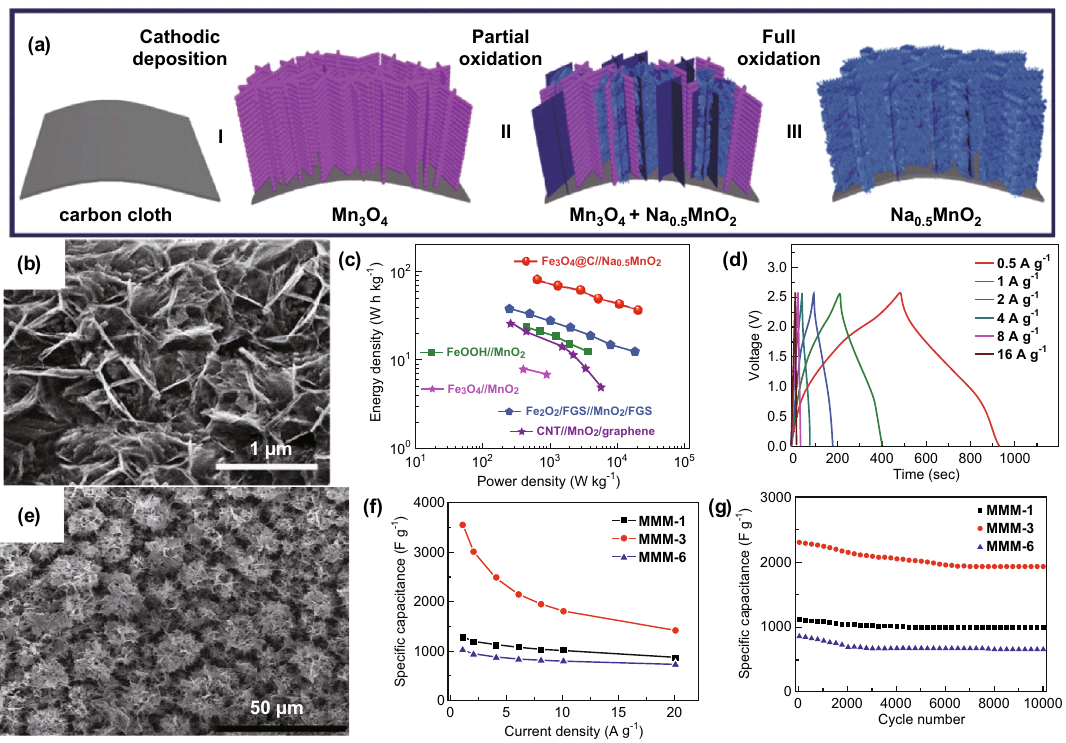
Fig. 4 3D architectures based on 2D transition metal nanoflakes and 3D skeleton ensembles for supercapacitors. a Schematic illustration of morphological evolution from Mn 3 O 4 nanowall arrays to Na 0.5 MnO 2 nanowall arrays through electrochemical oxidation. b FESEM images of Na 0.5 MnO 2 nanowall arrays. c Ragone plots for Na 0.5 MnO 2 //Fe 3 O 4 @C ASC and asymmetric supercapacitors reported in the literature. d Charge/ discharge curves for Na 0.5 MnO 2 //Fe 3 O 4 @C asymmetric supercapacitors between 0 and 2.6 V at different current densities. Reproduced with permission [70]. Copyright (cid:2) 2017, John Wiley & Sons, Inc. e SEM images showing the surface morphologies of nickel foam@rGO/Ag/Ni 3 S 2